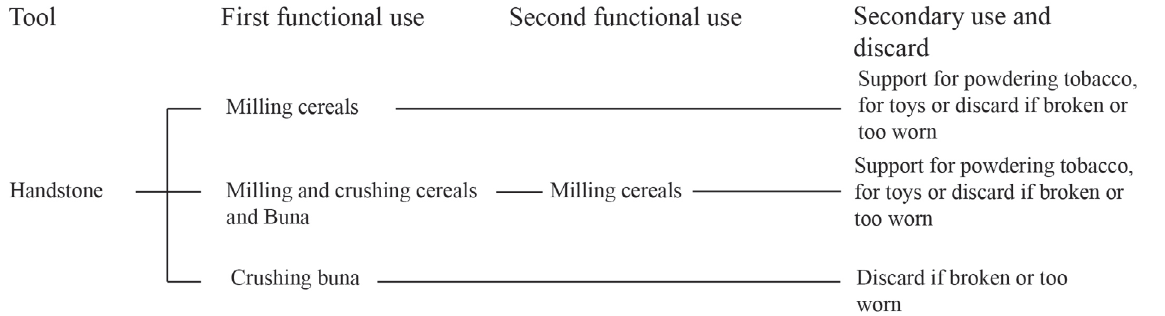
Figure 8. Functional, second functional, and secondary uses of handstones at